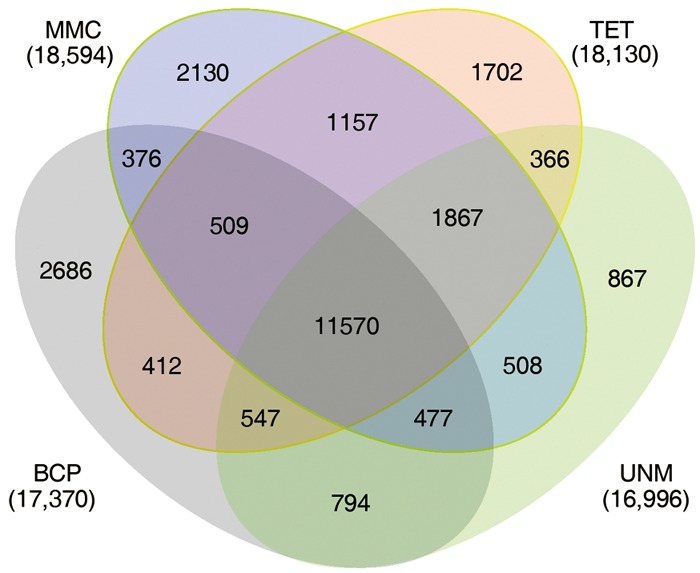
Expression patterns of highly expressed genes. The Venn diagram shows the constitution of genes highly expressed in at least one stage. The overlaps represent genes simultaneously highly expressed at two, three, or four stages.